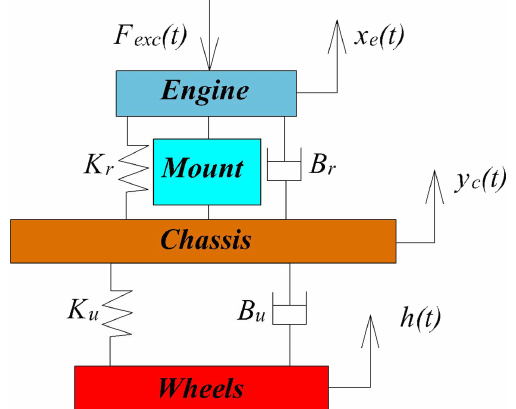
Figure 16. 1 / 4 vehicle model including fluid mount.